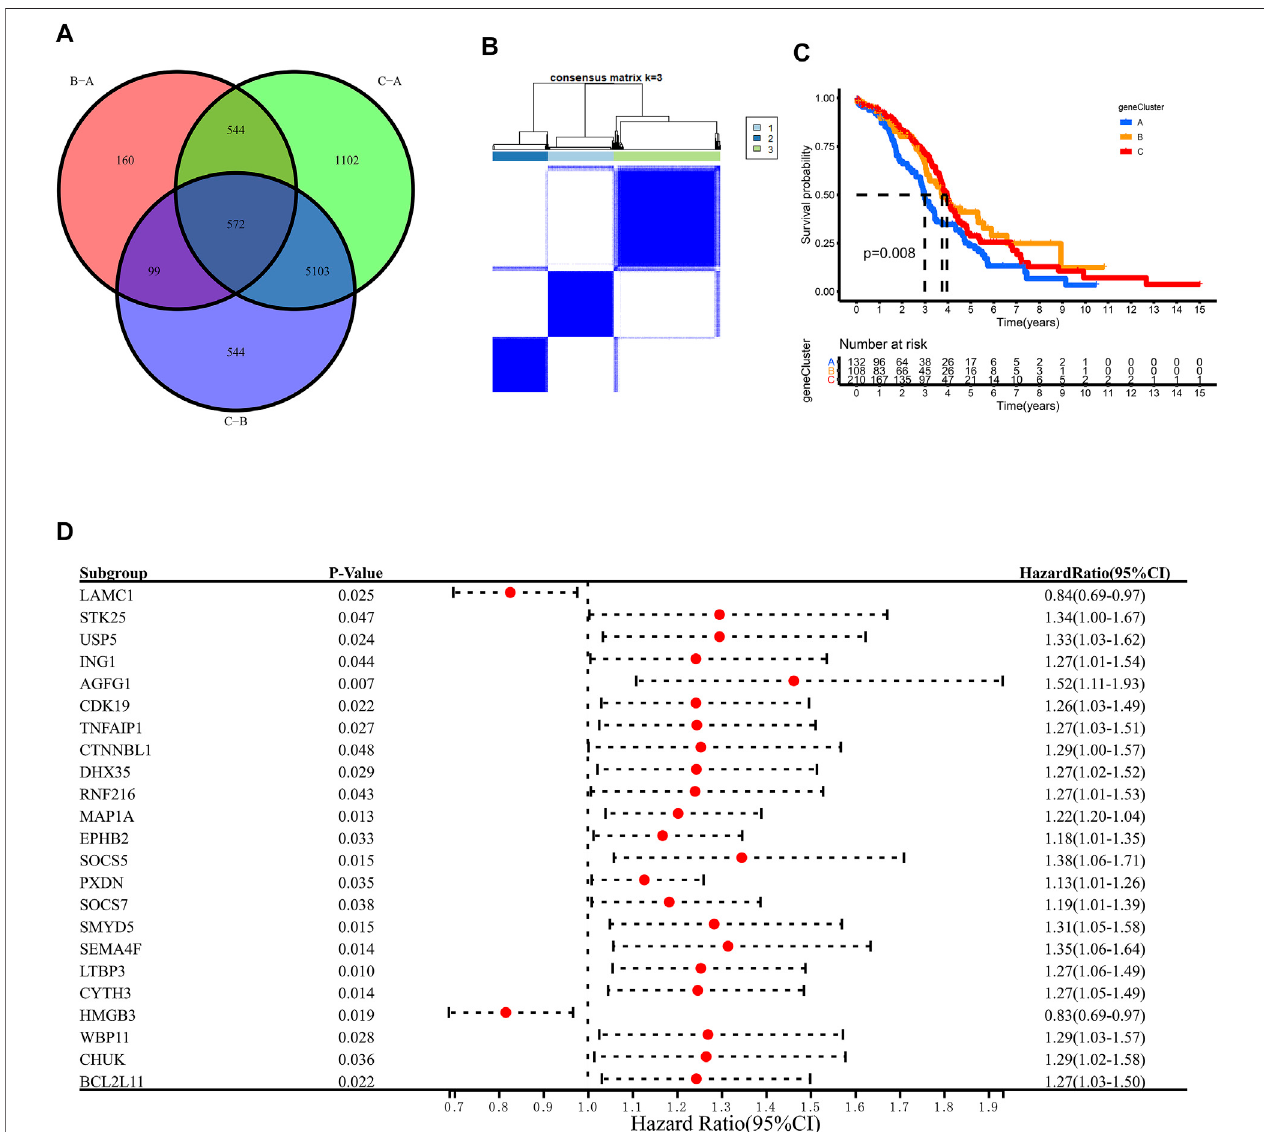
FIGURE 5 | Unsupervised clustering of 572 m6A phenotye-related genes according to TCGA and GSE14764 cohort. (A) 572 m6A phenotype-related genes shown in venn diagram. (B) Consensus matrices of 572 m6A phenotye-related genes according to TCGA and GSE14764 cohort for k (cid:1) 3. (C) Survial analysis for the three m6A modi fi cation patterns in TCGA and GSE14764 cohort. (D) The prognostic analysis for m6A phenotye-related genes in TCGA and GSE14764 cohort using a multivariate Cox regression model.